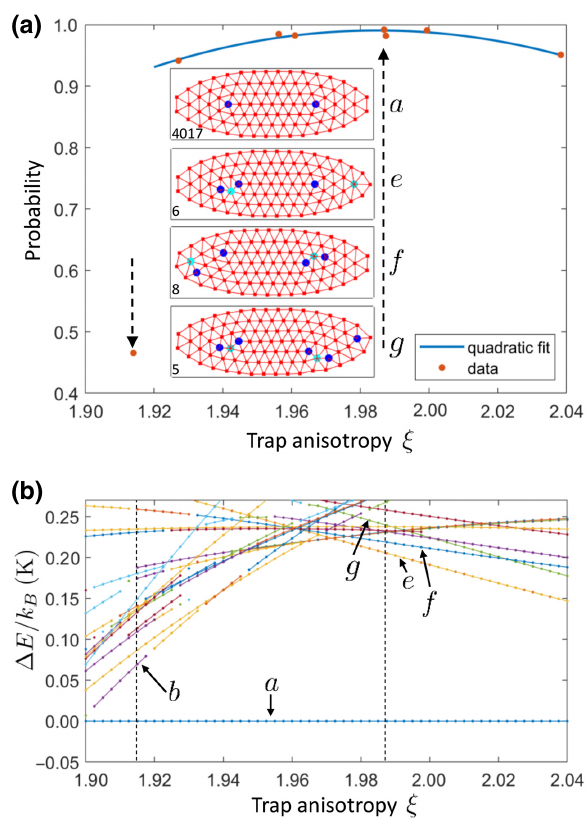
FIG. 6. Crystal configurations versus potential anisotropy for a 91-ion crystal. (a) The red points represent experimental data for the probability of finding the main configuration, max ( p i ) , as a function of trap anisotropy ξ . The blue line, a quadratic fit, pro- vides a guide for the eye for data in the stable regime, where the probability of being in the main configuration exceeds 90%, and can be used to find the optimum anisotropy. After optimization of ξ , the main configuration (labeled “ a ”) is found in more than 99% of all 4050 images taken (upward-pointing arrow), whereas configurations e – g are observed only a few times, as indicated by the numbers next to them. The downward-pointing arrow indi- cates the value of ξ for which the data in Fig. 5 are taken. (b) Numerical simulations of metastable configurations reproduce many configurations found in the experiment. Moreover, they show that the energy gap between metastable configurations and the ground state becomes maximal close to the value of ξ for which the crystal lattice is stablest in the